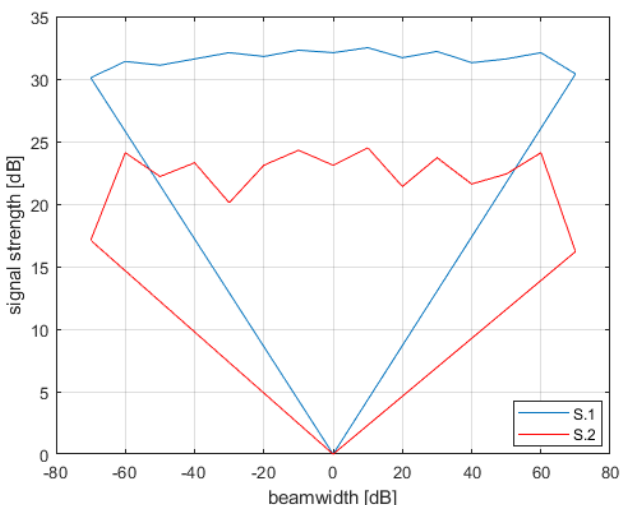
Figure 16. Comparison between the signal strength in S.1. (blue) and S.2. (red) setup with the Portable Ground Station (PGS) in vertical.